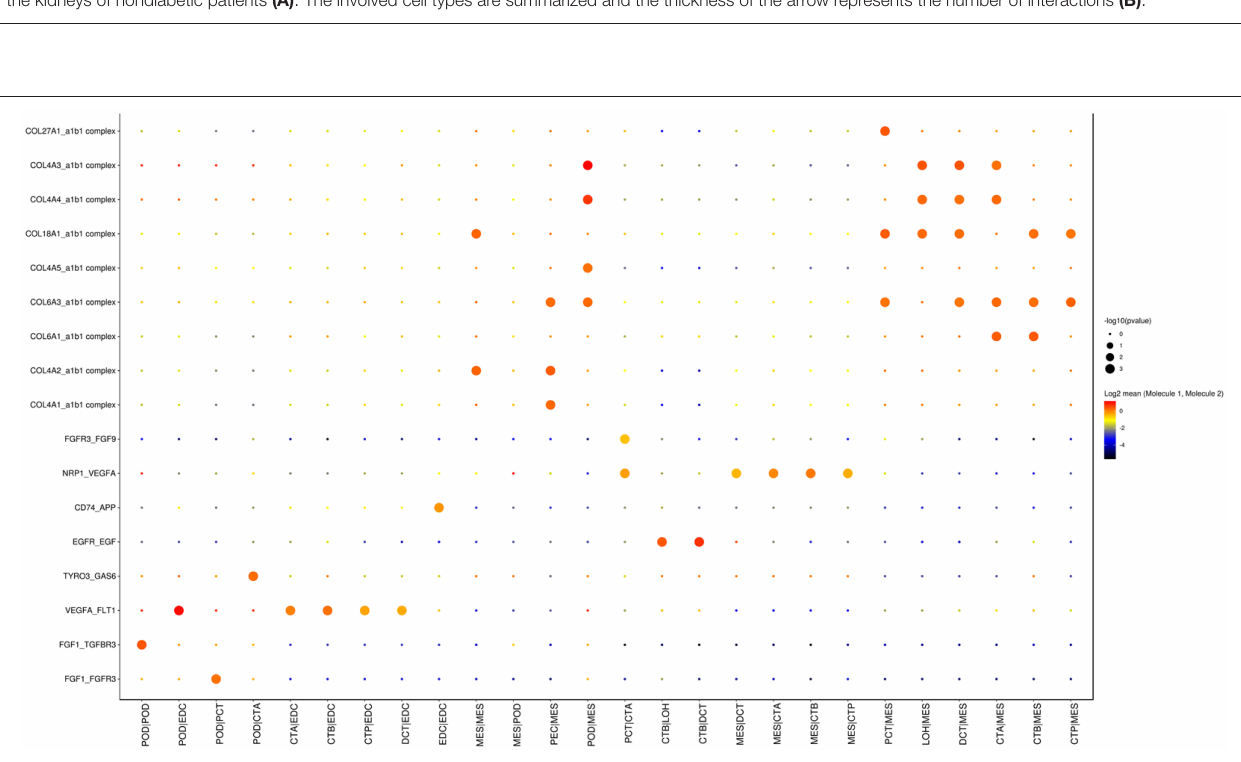
FIGURE 5 | Cell cross-talk in the kidneys of diabetic patients. We analyzed all individual cells based on ligand-receptor interactions to reveal the cell cross-talk in the kidneys of diabetic patients.